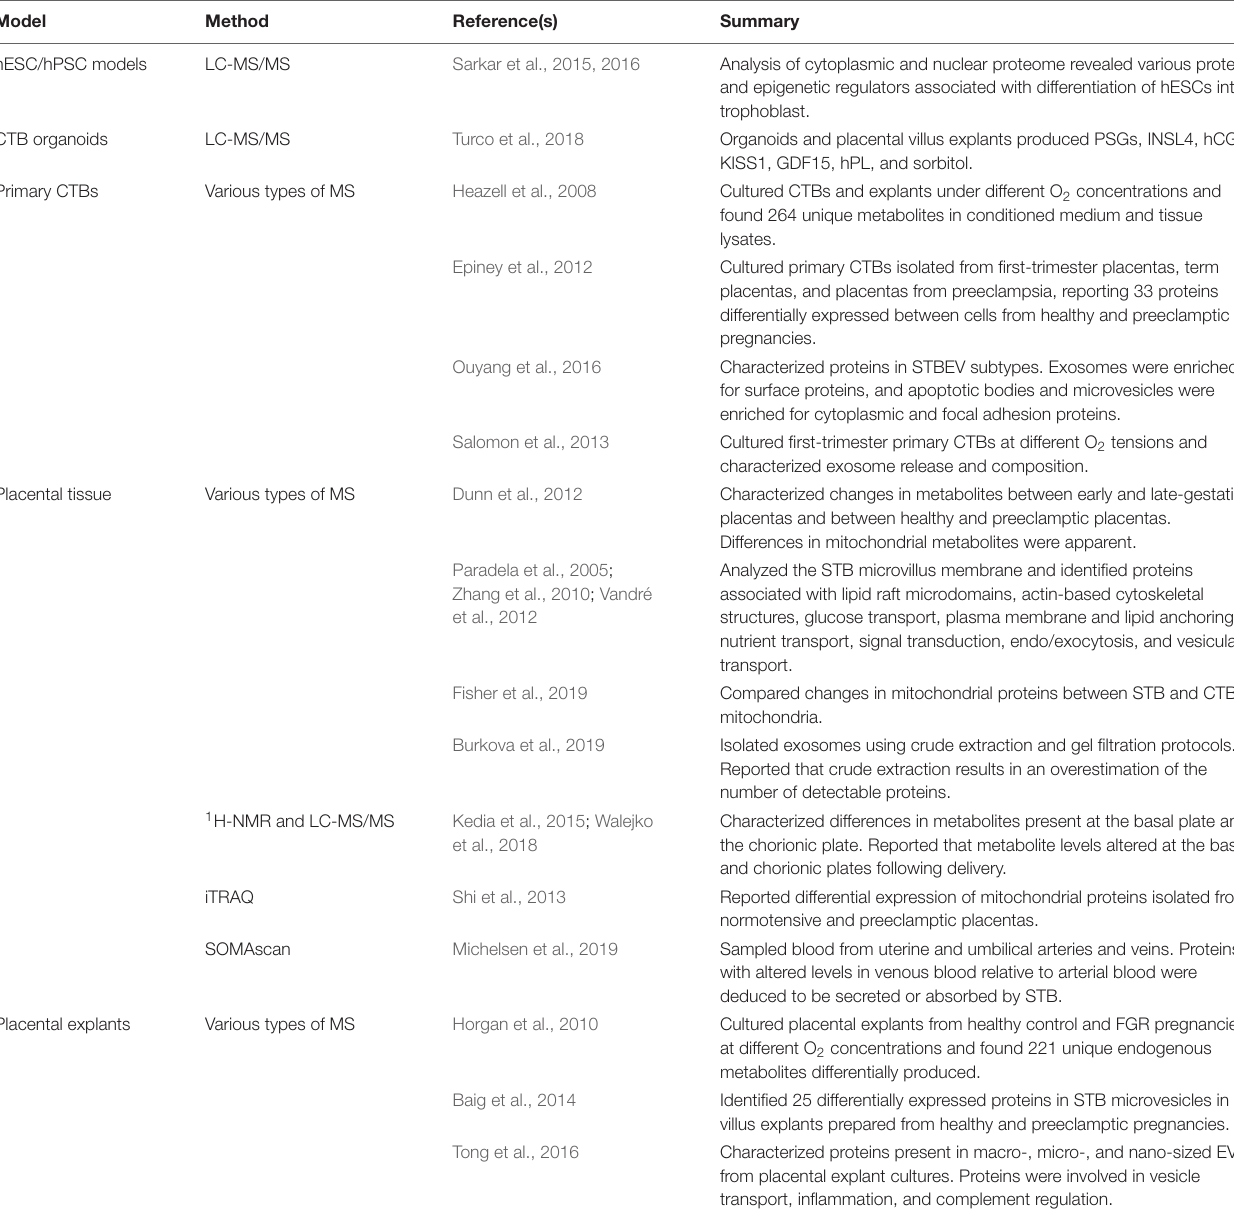
TABLE 3 | Examples of studies that used proteomics, metabolomics, and secretomics to characterize STB